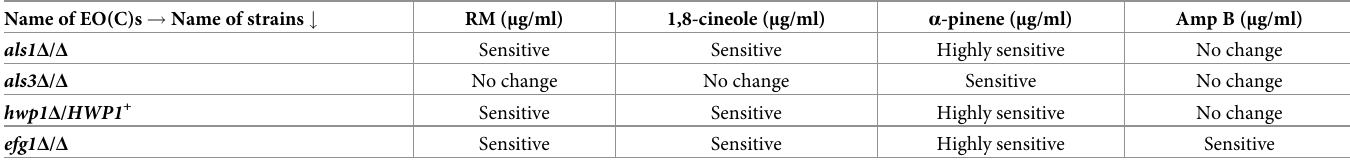
Table 1. Summary of mutant strain sensitivity. Name of EO(C)s ! Name of strains